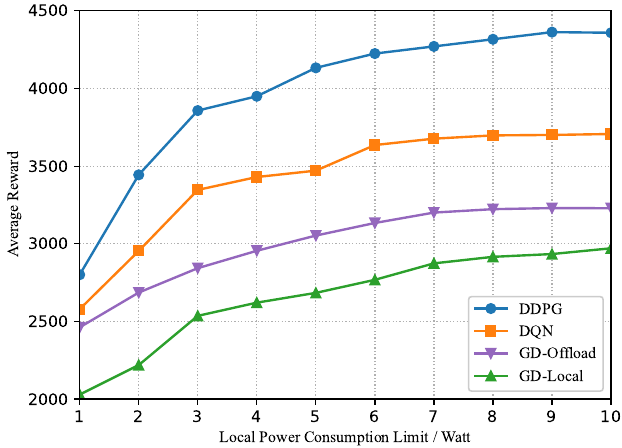
Figure 11. Average reward versus threshold of local power